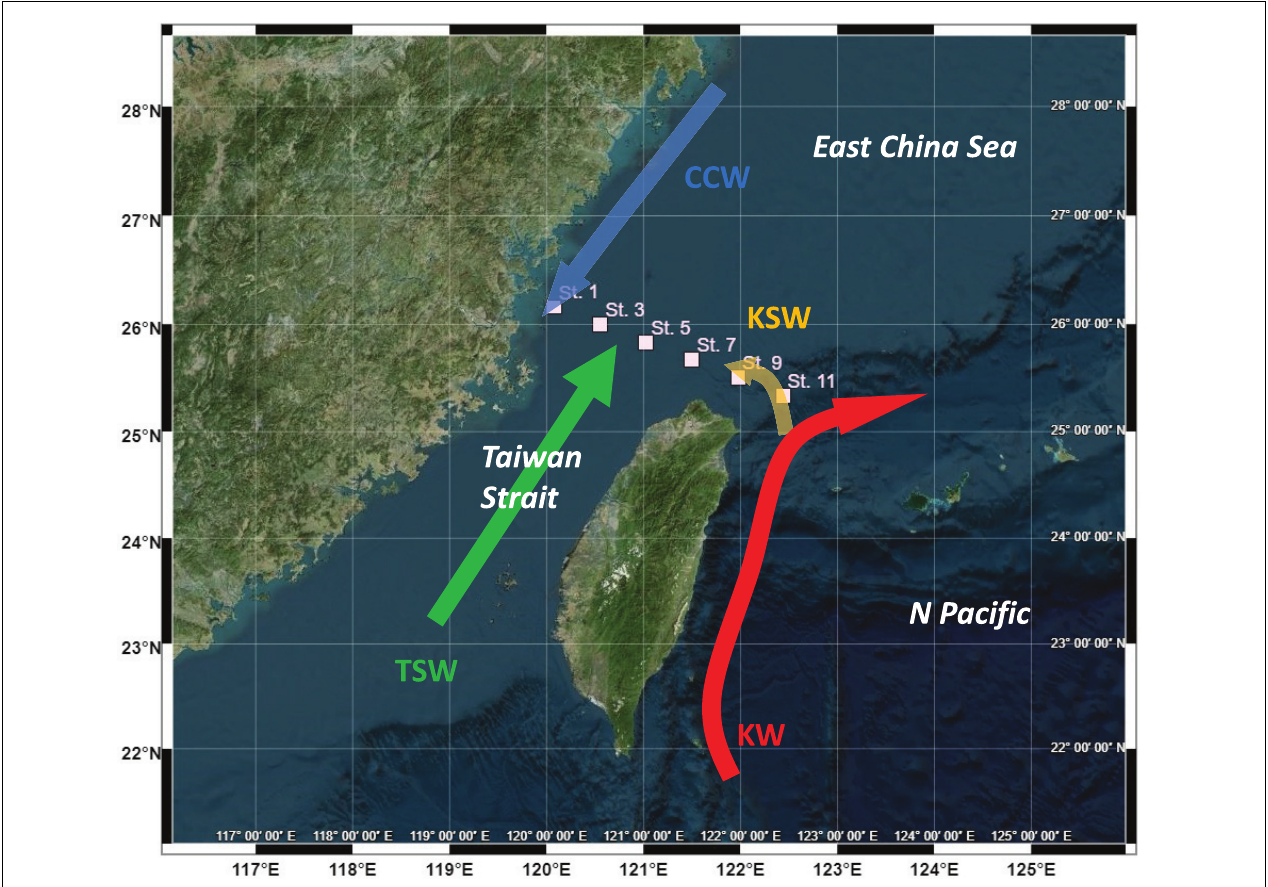
FIGURE 1 | Sampling sites with different water masses. KW denotes Kuroshio waters; KSW denotes upwelling Kuroshio subsurface waters; TSW denotes Taiwan Strait waters; CCW denotes China coastal waters.